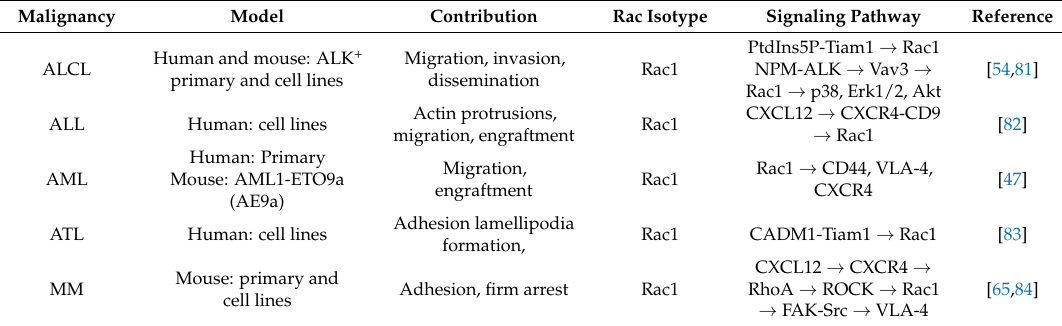
Table 2. Contribution of Rac1 to migratory